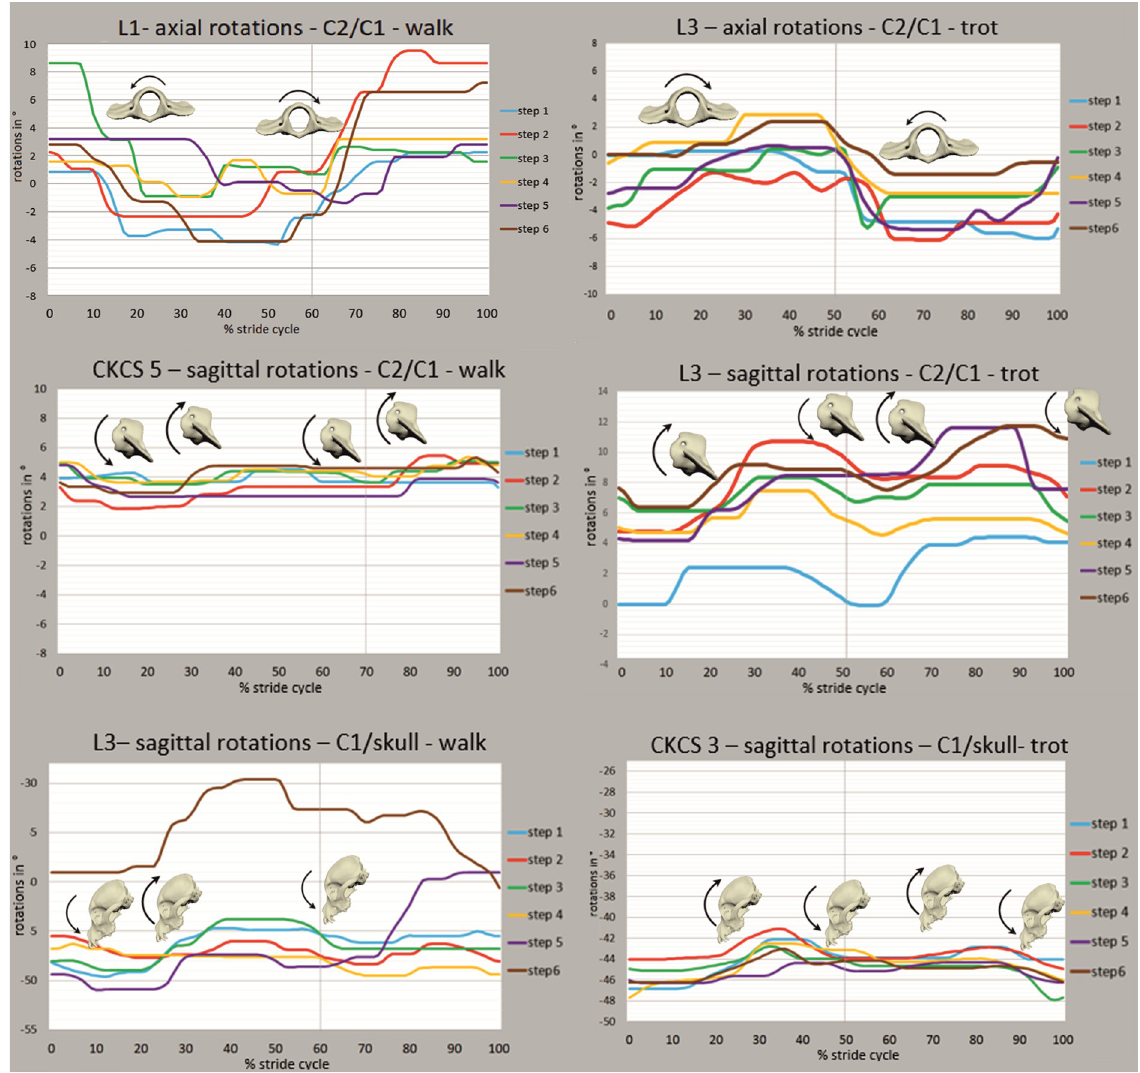
Fig 7. Examples of phase-normalised movements of the atlantoaxial (C2/C1) and atlantooccipital (C1/skull) joint in walk and trot. All stride cycle-dependent rotational degrees of freedom in CKCSs and Labrador retrievers in six strides. X-axis represents one complete stride cycle from touchdown (0%) to subsequent touchdown (100%) of the left hind limb. Y-axis represents the motion amplitude in ˚. The vertical line represents the duty factor. Bone models and arrows indicate direction of stride cycle-dependent bone